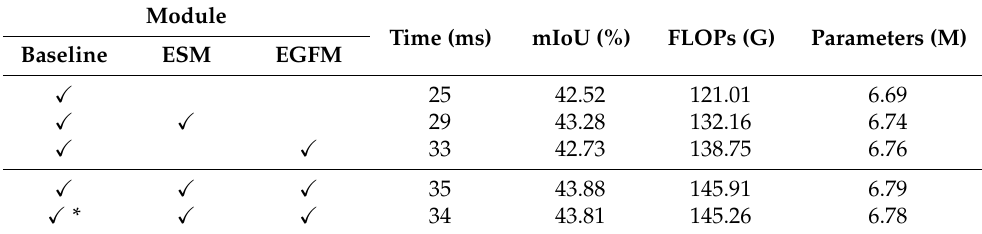
Table 3. Quantitative evaluation of ablation studies on the RELLIS-3D dataset.